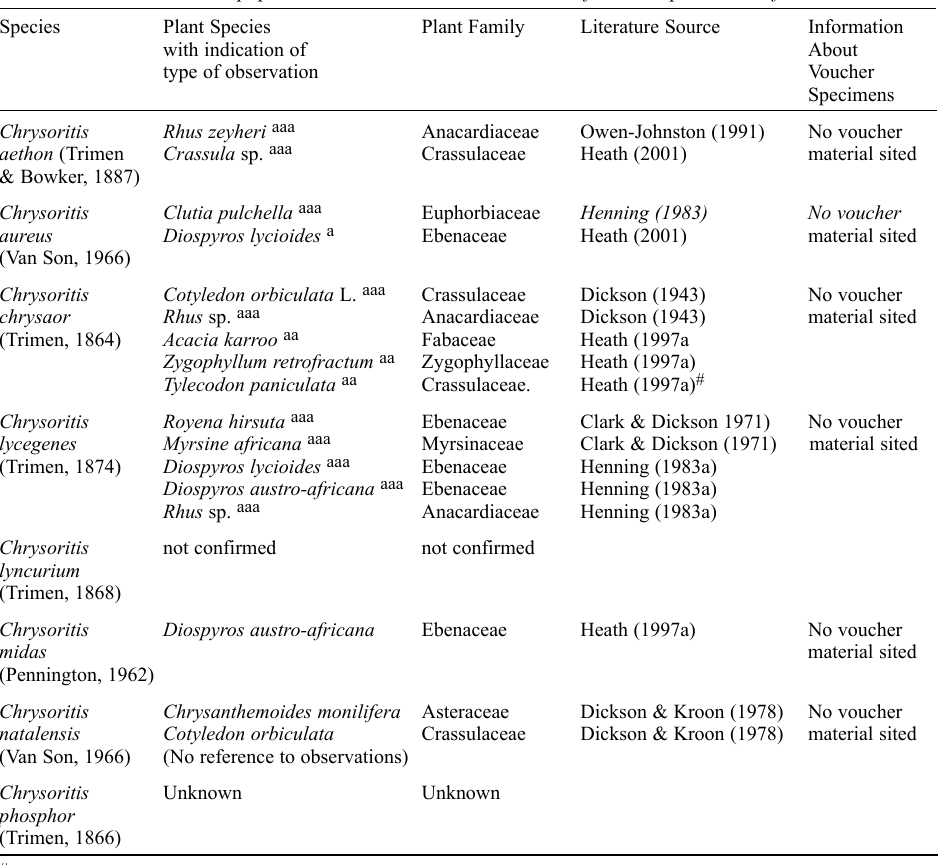
Table 3 Summary of the host plants used by species belonging to the C. chrysaor species group in the genus Chrysoritis and the literature source where the host plant was first reported. a Larvae were bred on the plant in captivity or in the laboratory. aa Only oviposition on the plant observed (Heath 1997). aaa Larvae or pupae were observed on or at the base of the host plant in the field